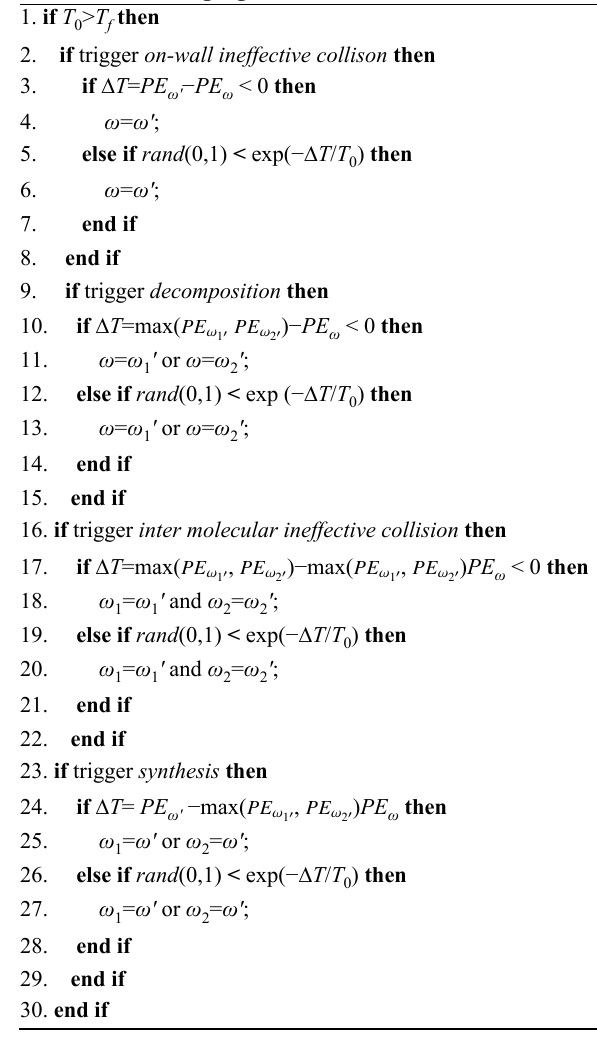
Algorithm 2 A new solution acceptance method based on simulated annealing